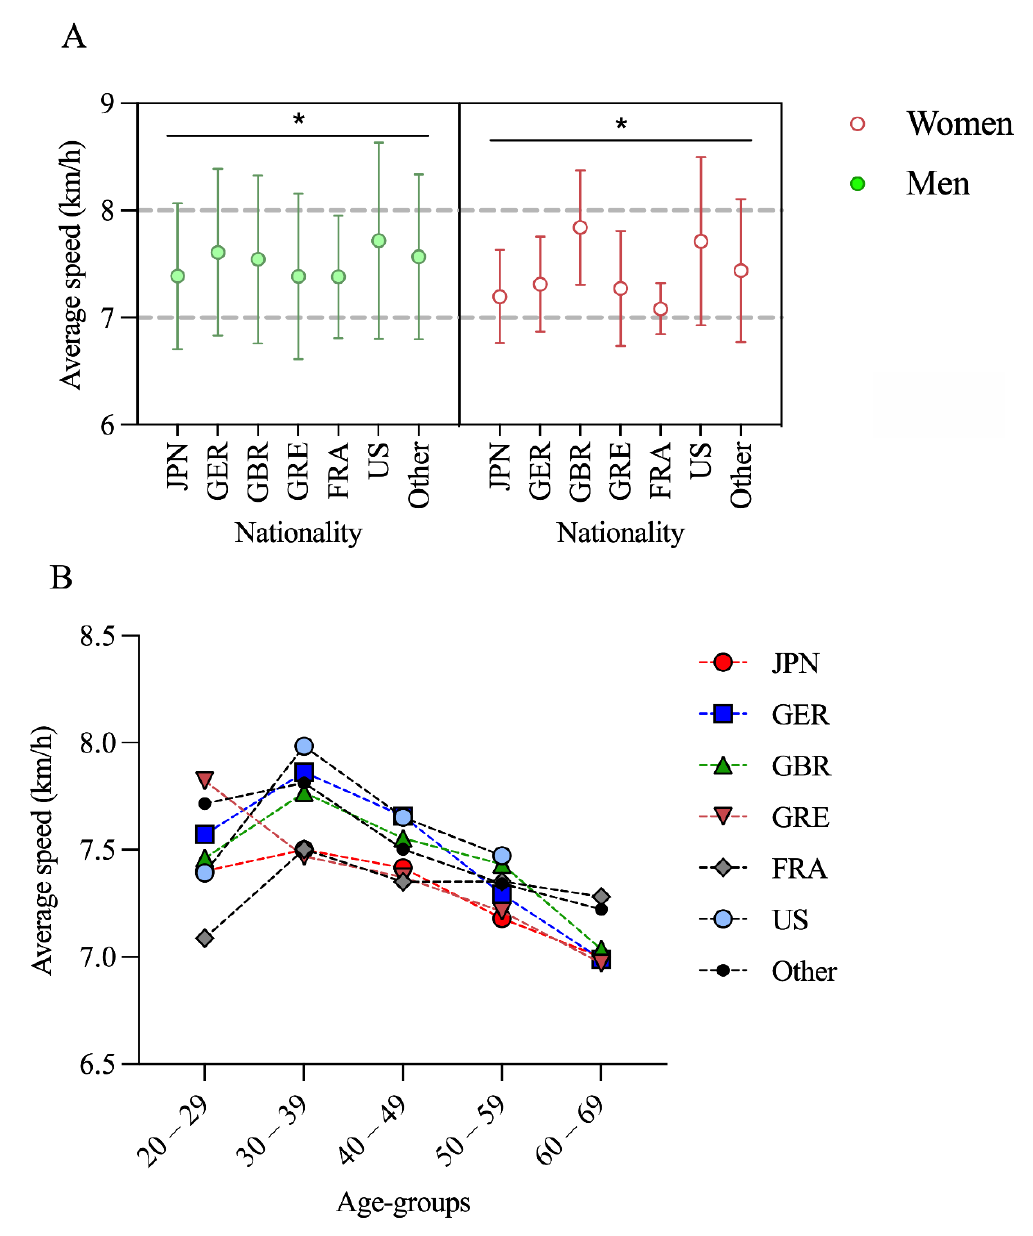
Figure 3. ( A ) Performance of men and women from different nationalities in the Spartathlon; ( B ) performance by nationality and age groups; *: statistically significant nationality effect ( p < 0.05).